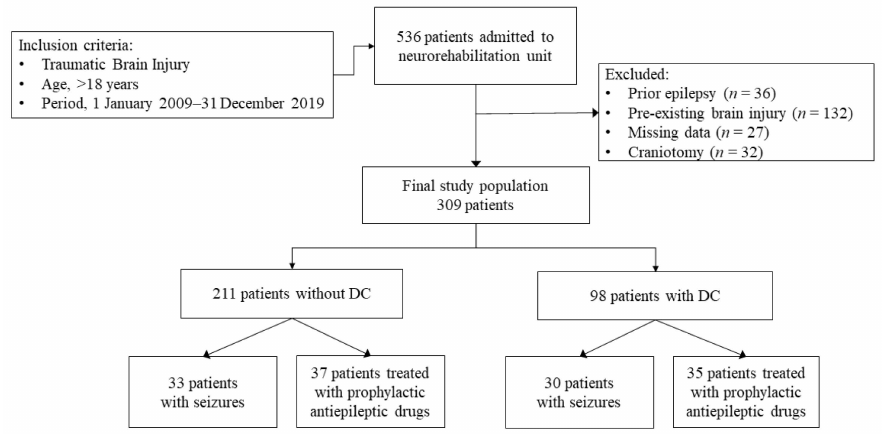
Figure 1. Traumatic brain injury patients flow